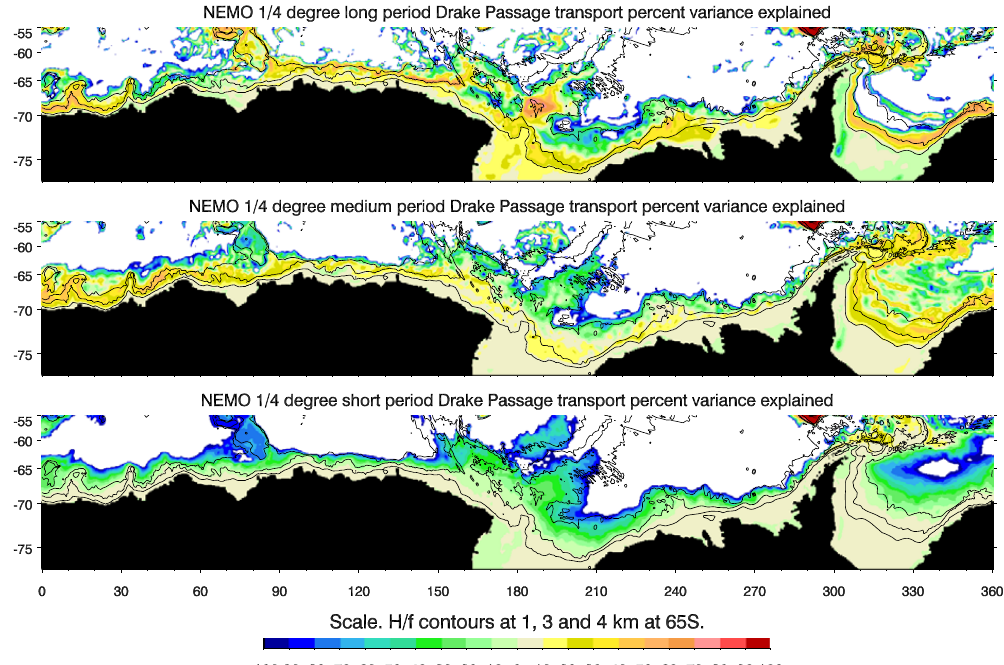
Fig. 7. The percentage of variance in Drake Passage transport which is explained by the total zonal transport integrated across a section reaching northwards from Antarctica to each grid point. Annual, semiannual, and linear trend have been subtracted before filtering to pass periods shorter than 2 years (short), periods 2–6 years (medium) and periods longer than 6 years (long) in the three panels. Values below − 100% are left